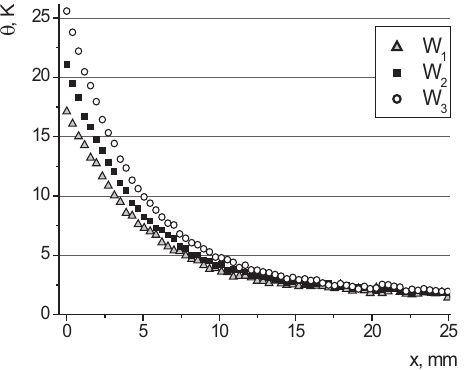
Fig. 2. Temperature distribution along the fin for three power levels (W) supplied to the heater during boiling of distilled water Boiling is highly effective in dissipating heat and temperature drops and approaches the saturation tem- perature within a small distance from the fin’s base. Based on the numerical differentiation of the res- ults from figure 2, it is possible to produce a dependence of temperature gradient as a function of superheat from three levels of power supplied to the heater. The results are illustrated in figure 3.